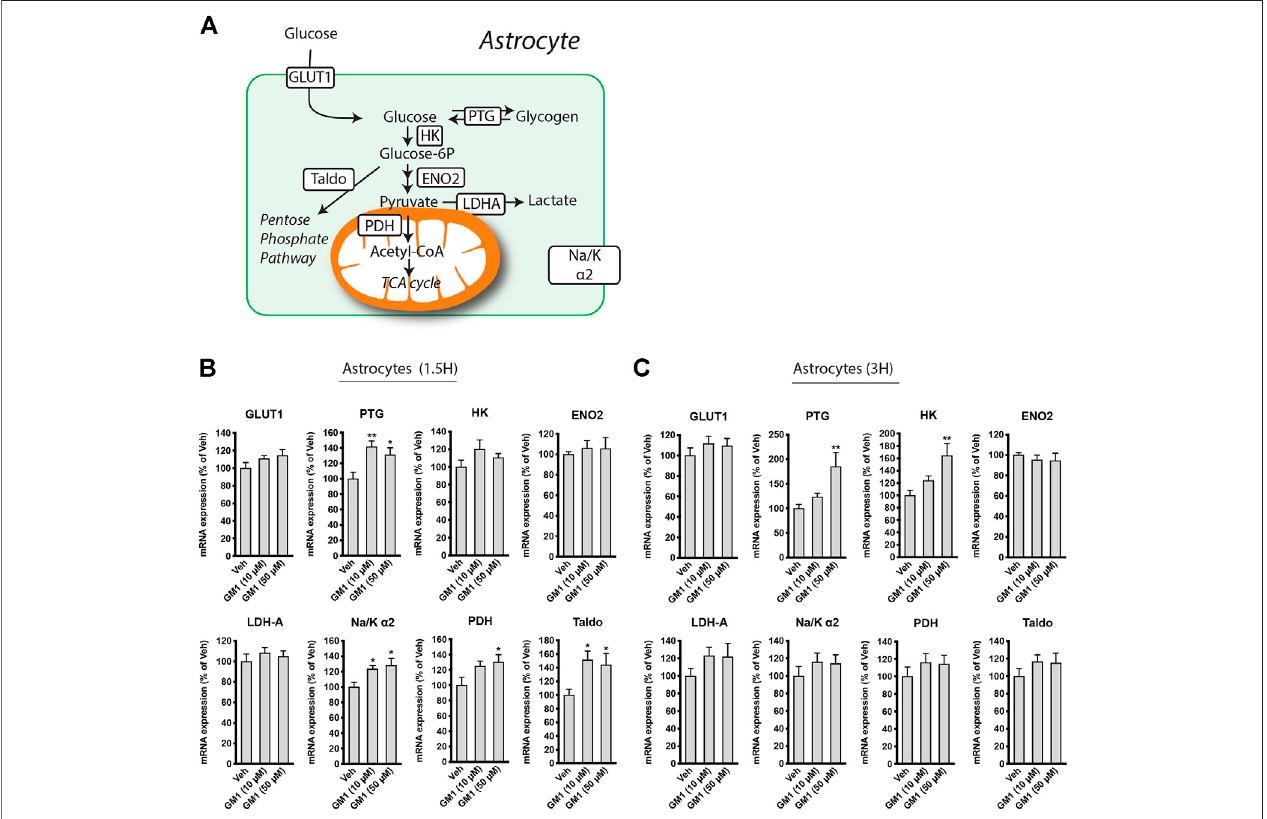
FIGURE 3 | Regulation of astrocytic metabolic genes expression by GM1. (A) Scheme representing genes involved in astrocytic glucose metabolism pathways, including Glucose Transporter 1 ( Glut1 ), Protein Targeting to Glycogen ( Ptg ), hexokinase ( HK ), Enolase 2 ( Eno2 ), Lactate dehydrogenase A ( Ldha ), Na + /K + ATPase subunit α 2 ( Na/K α 2 ), Pyruvate dehydrogenase ( Pdh ) and Transaldolase ( Taldo ). (B,C) Regulation of Glut1 , Ptg , HK , Eno2 , Ldha , Na/K α 2 , Pdh and Taldo after treatment ofastrocyteswithVeh(DMSO0.1%)orGM1(10and50 μ M)for1 h (B) or3 h (C) .Dataareshownastheaverage+SEMofmRNAexpressionlevels,representedas % of Veh ( n (cid:2) 12). Statistical analyses consisted in one-way ANOVA followed by Dunnett ’ s post-hoc test; * p < 0.05, ** p < 0.01, *** p <